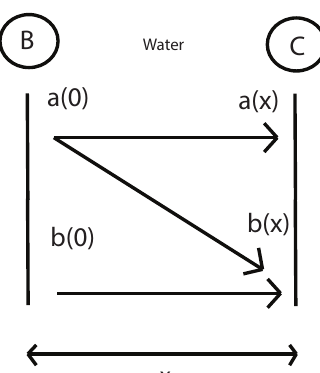
Figure 7. Determination of the fundamental and second harmonic in B by propagating this values from C to